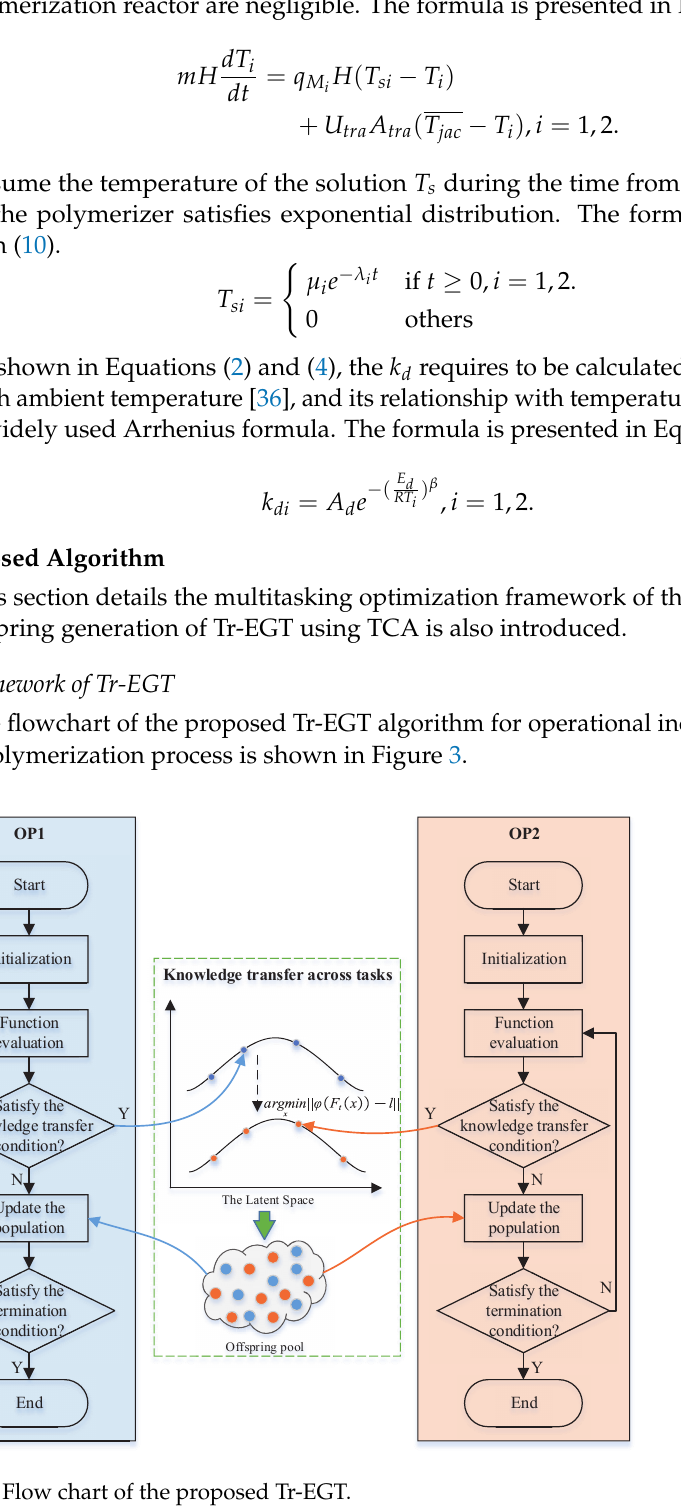
Figure 3. Flow chart of the proposed